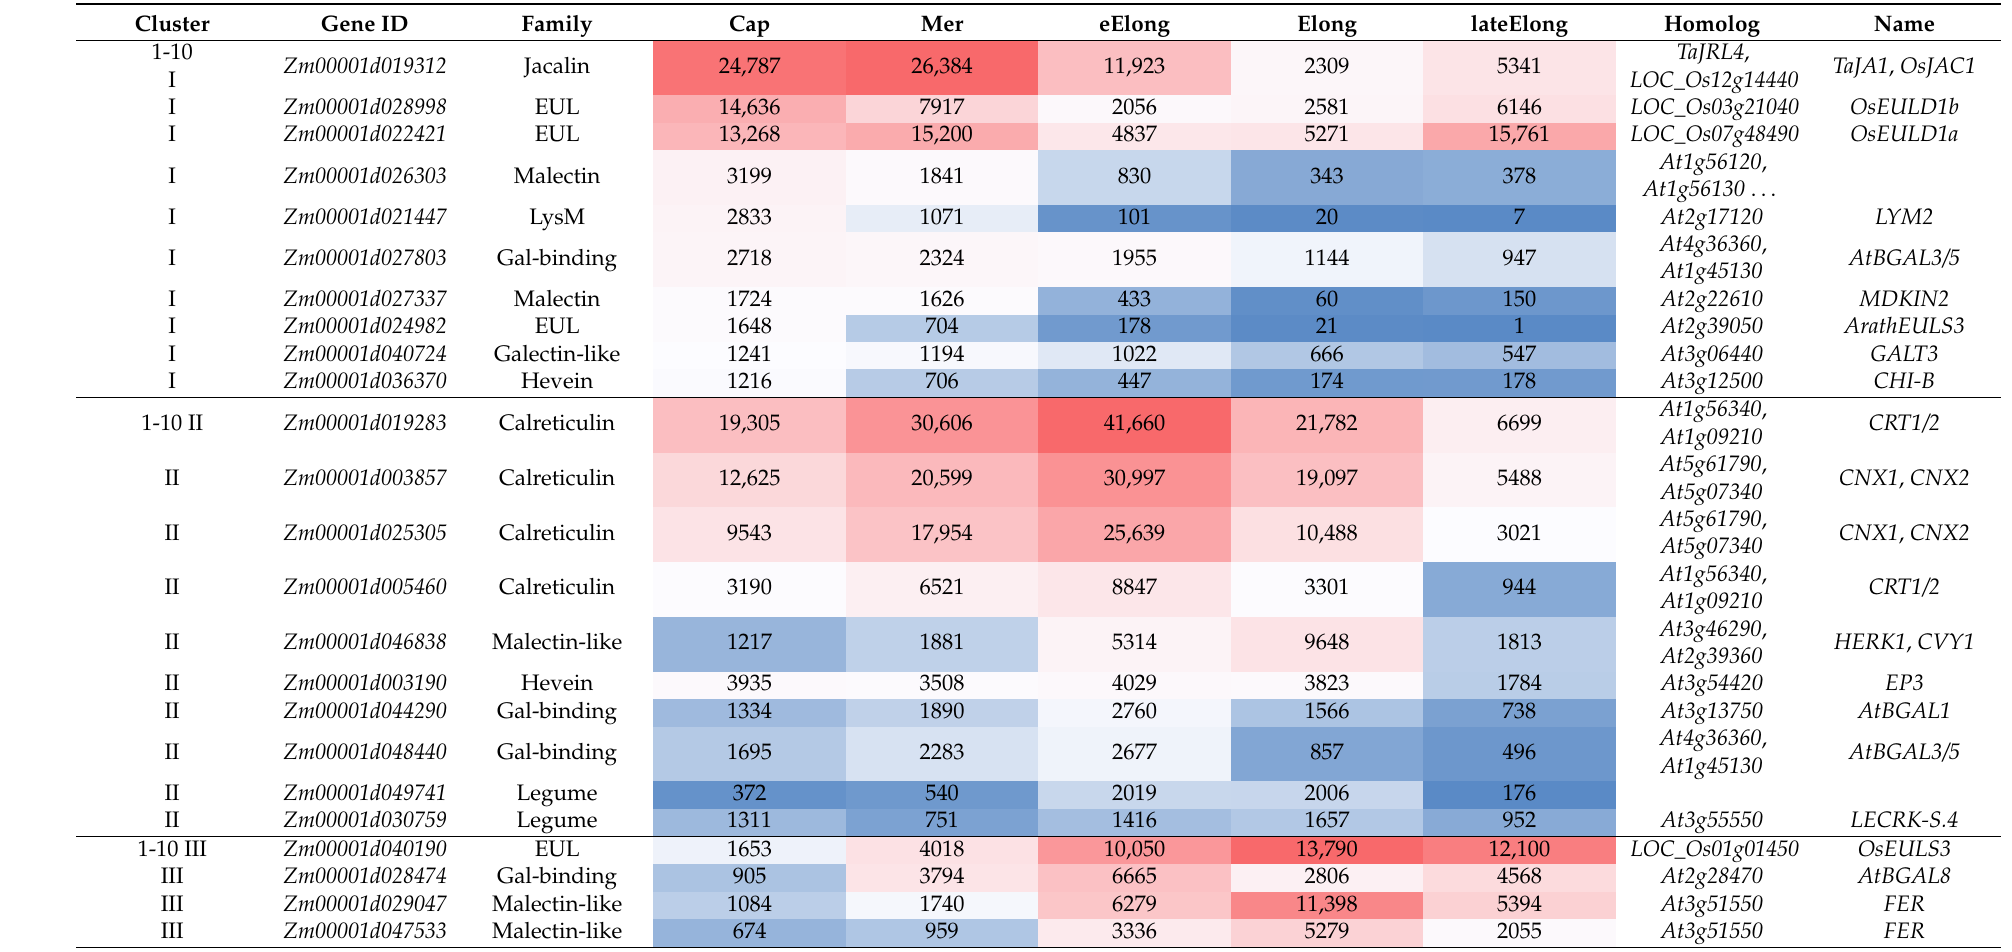
Table 2. Top 10 maize genes encoding proteins with lectin domains for each of the gene expression clusters found in growing maize